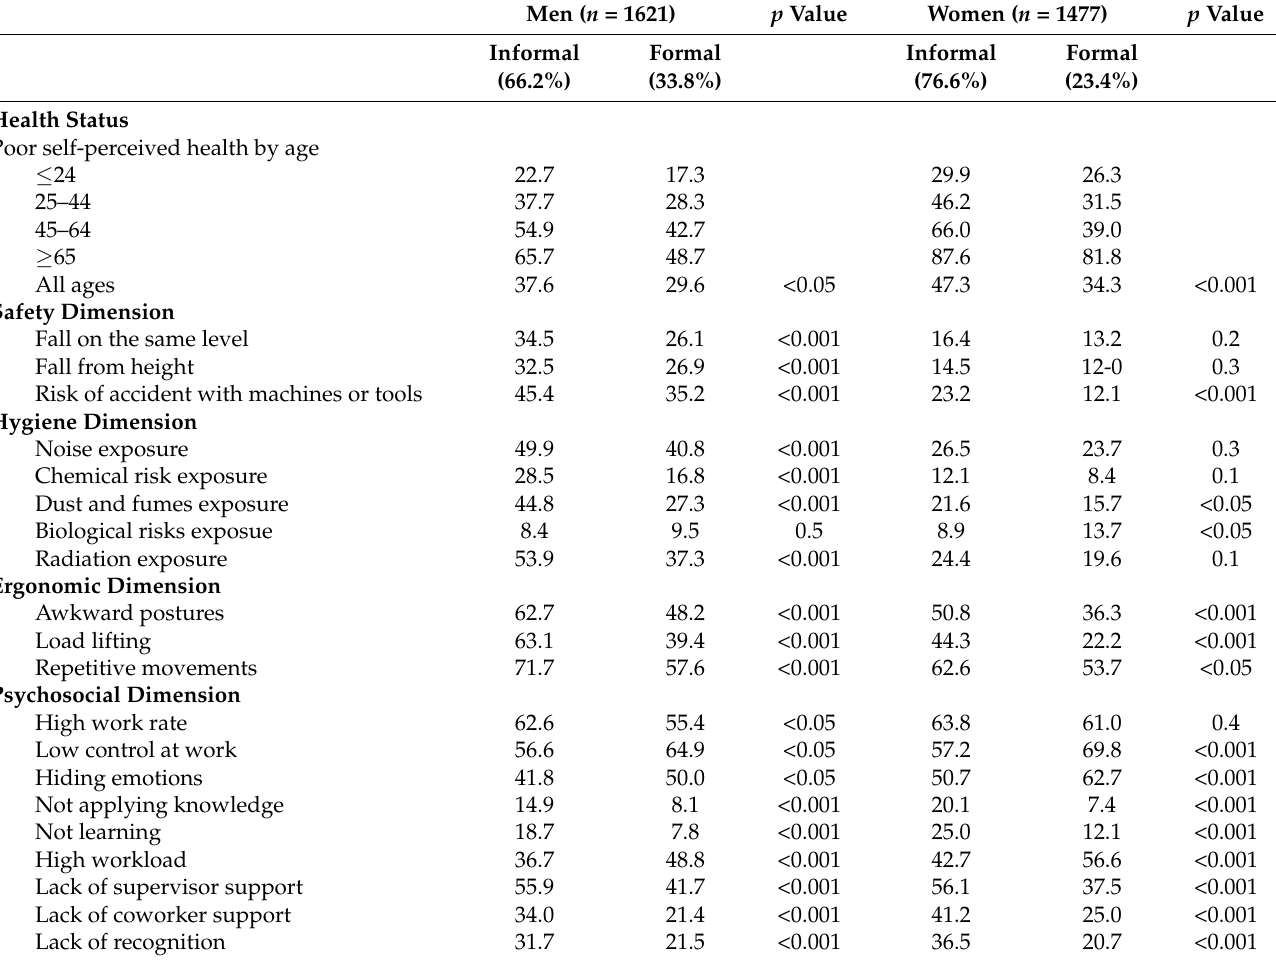
Table 1. Prevalence of poor working conditions and poor self-perceived health in the working population, stratified by sex and employment status, working conditions survey of Peru 2017. Men ( n =